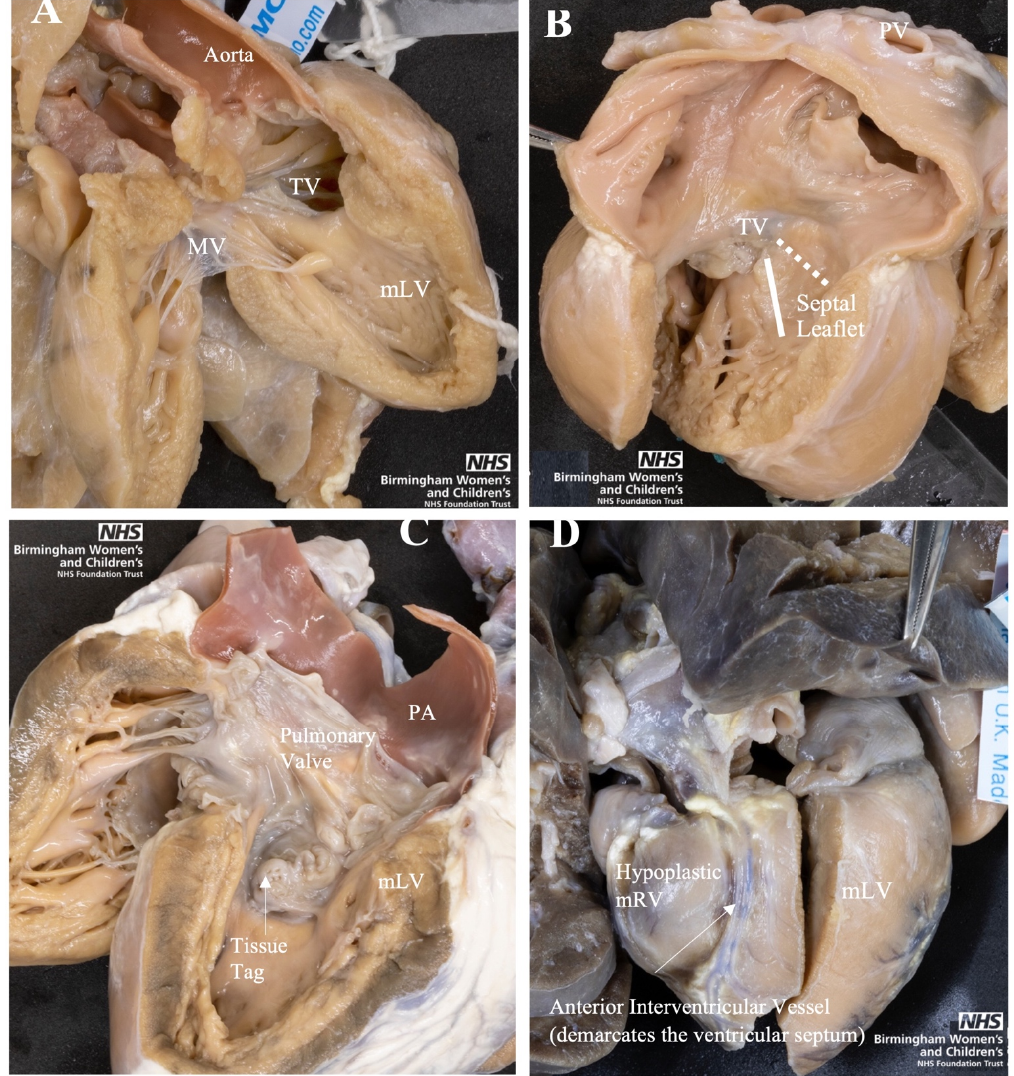
Figure 4. Four Associated Anomalies of ccTGA. ( A ) Peri-membranous VSD with aorta overriding and tricuspid valve straddling, from the morphological left ventricle (mLV). ( B ) Septal leaflet is plastered to septum of morphological right ventricle (mRV). Dashed line shows normal atrioventricular junction and solid line shows apical displacement of septal leaflet. ( C ) Subpulmonary obstruction due to tissue tag of septal leaflet of tricuspid valve. ( D ) Ventricular hypoplasia of the mRV. MV, Mitral Valve; PV, Pulmonary Vein; TV, Tricuspid Valve; mLV, morphological left ventricle; mRV, morphological right ventricle; mLA: morphological left atrium.